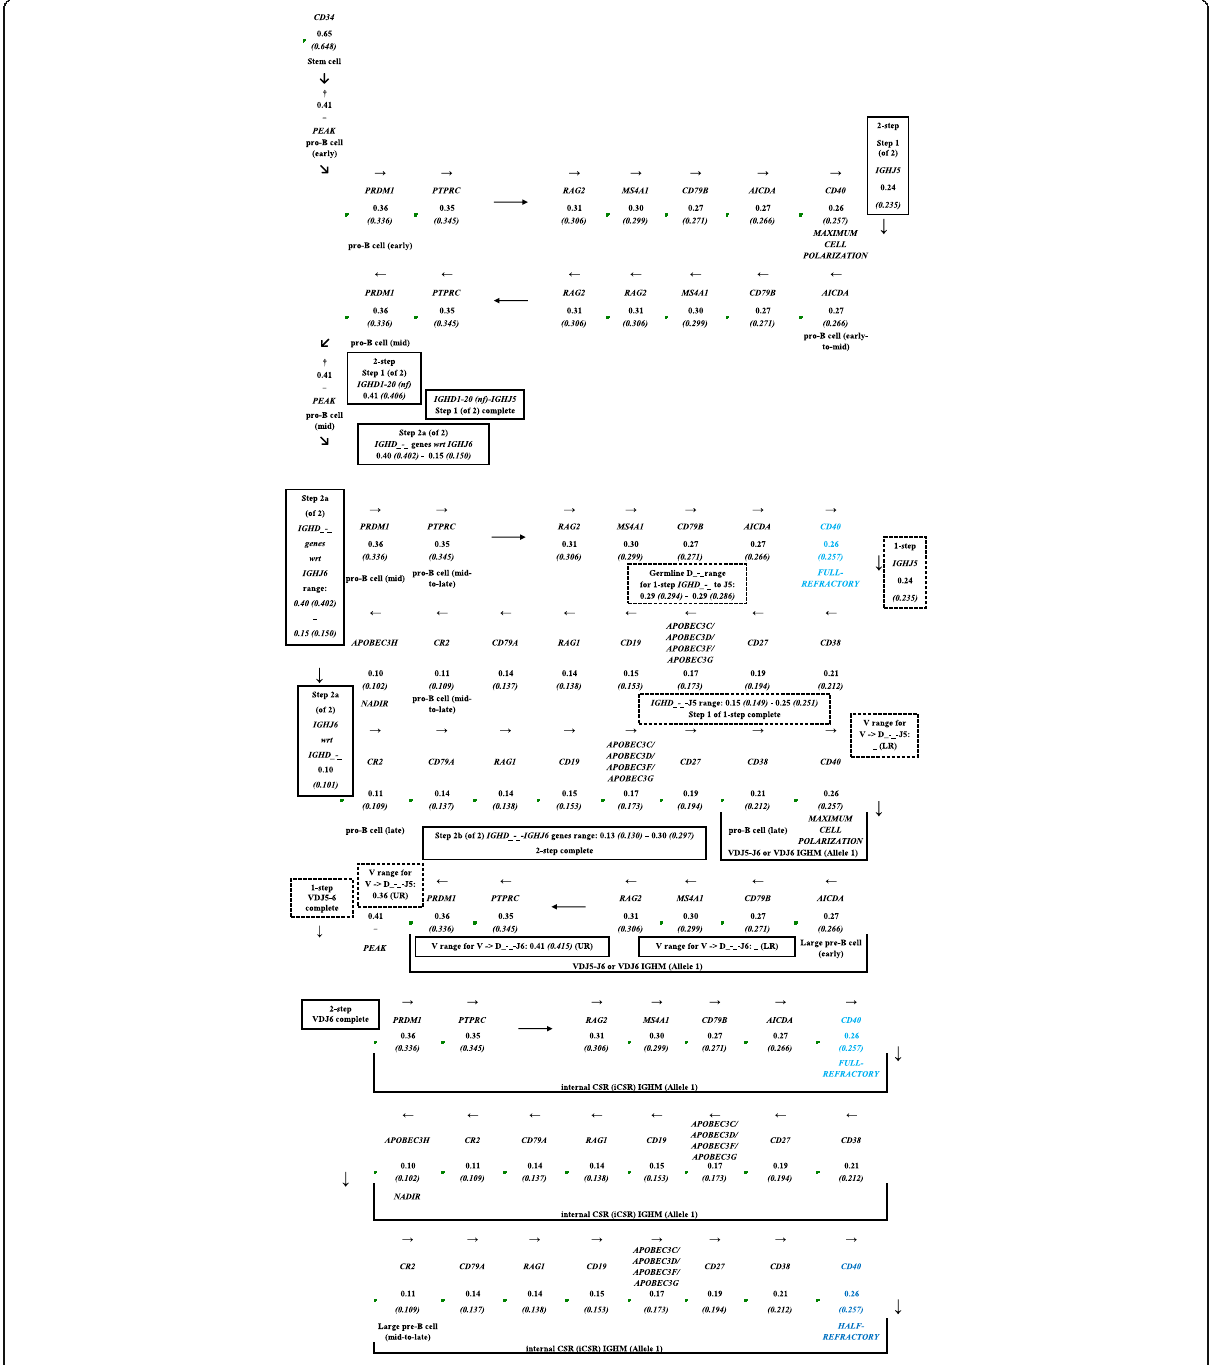
Fig. 1 Allele 1 (IGHM) 2-step and 1-step Ig heavy chain locus gene rearrangement recombination steps superimposed on the pressuromodulation map of B-cell differentiation stages. The Allele 1 two-step recombination steps are IGHD1 – 20 (nf) and IGHJ5 recombination (step 1 of 2), IGHD_-_ genes with respect to D1 – 20(nf)-J5 (step 2a of 2) and IGHJ6 with respect to D1 – 20(nf)-J5 (step 2a of 2) recombination that results that results in IGHD_-_ - IGHJ6 (step 2b of 2) through the final IGHV_-_ and IGHD_-_-IGHJ6 recombination that results in V_-_-DJ6 . The Allele 1 one-step recombination step is IGHD_-_ and IGHJ5 recombination that results in IGHD_-_ - IGHJ5 (step 1 of 1) through the final IGHV_-_ and IGHD_-_-J5 recombin- ation that results in V_-_-DJ6 . Note: Allele 1 locus rearrangement recombination steps complete to the point of the CM IgM+ B-cell before Allele 2 VDJ completes. † , upper esebssiwaagoT Q units range, 0.41 – 0.36. Black, CD40 at maximum cell polarization potential. Dark blue, CD40 at half-refractory. Light blue, CD40 at full-refractory. Text boxes with complete borders, 2-step. Text boxes with dashed borders, 1-step. Large rectangular box with complete borders, extra-nodal secretory antibody